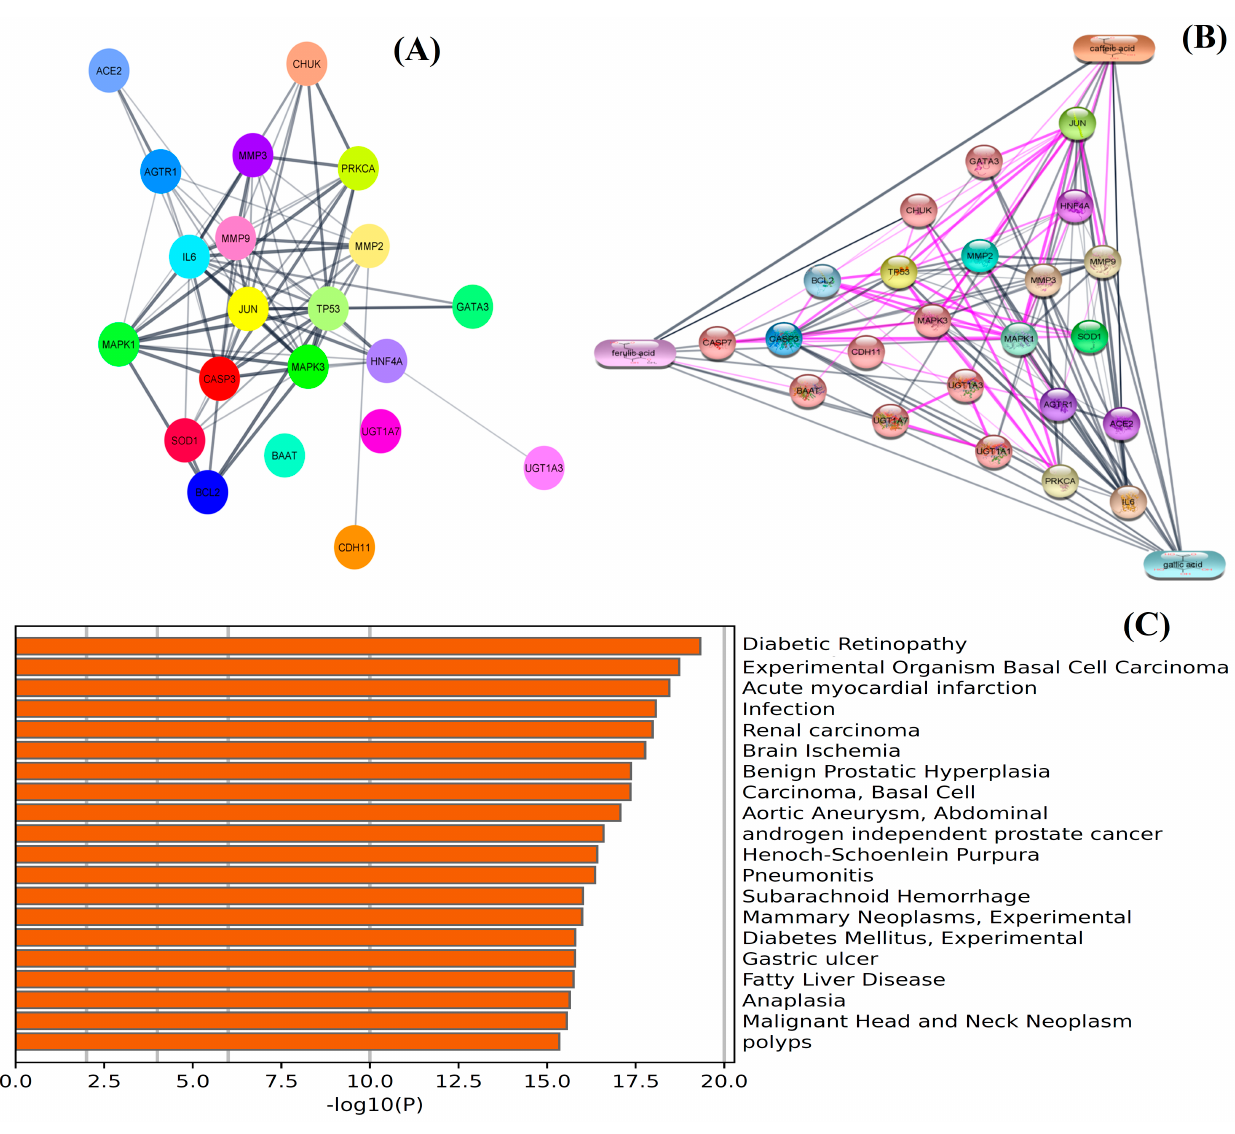
Figure 3. Network pharmacology analysis: ( A ) represents PPI network and ( B ) represents CPI network of integrated genes, while ( C ) represents GO analysis of screened genomes in the pathophys- iology of kidney disease and associated disorders.